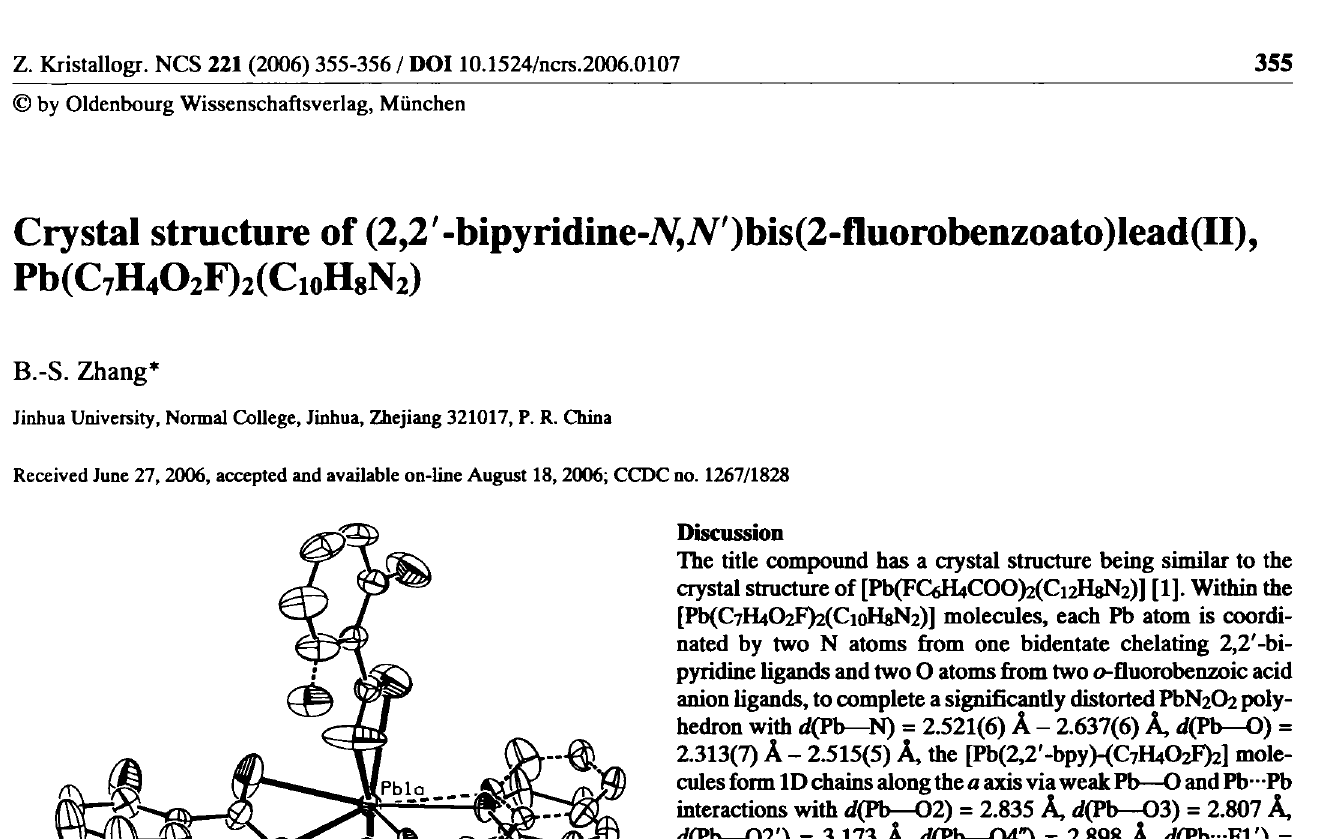
Table 1. Data collection and handling.